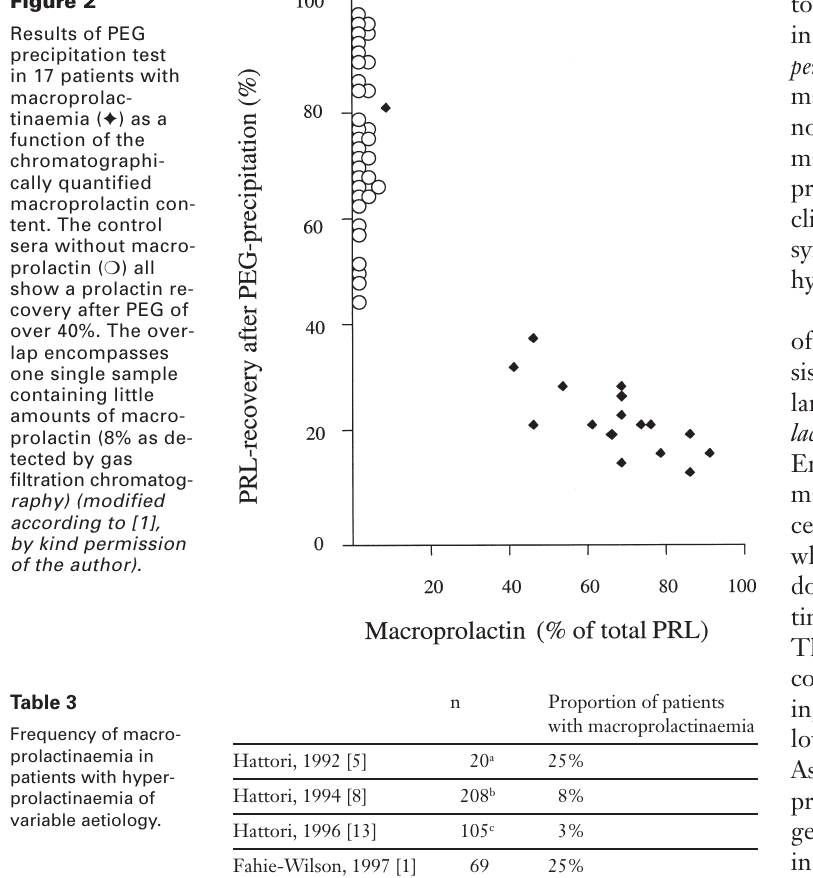
Frequency of macro- prolactinaemia in patients with hyper- prolactinaemia of variable aetiology.